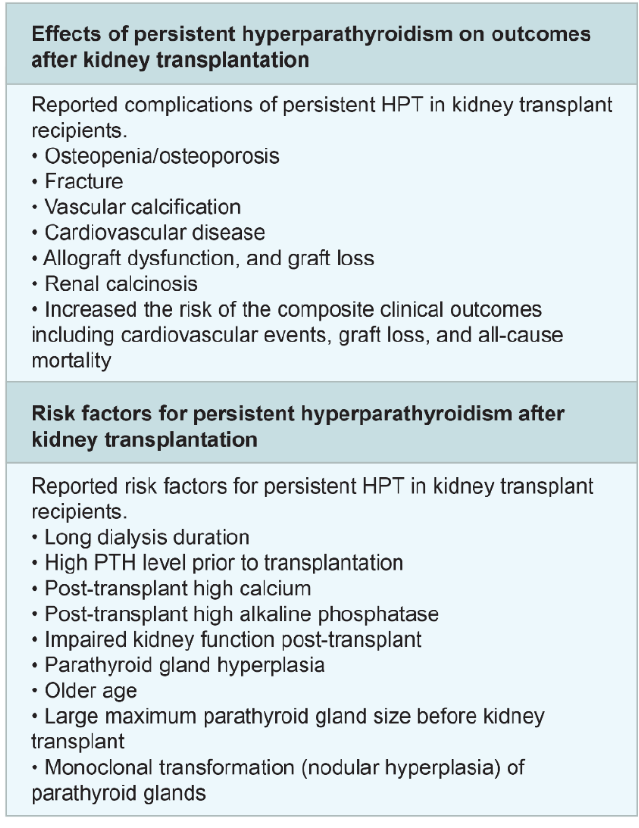
Figure 3. Effects and risk factors of post-transplant hyperparathyroidism. Figure 3. E ff ects and risk factors of post-transplant